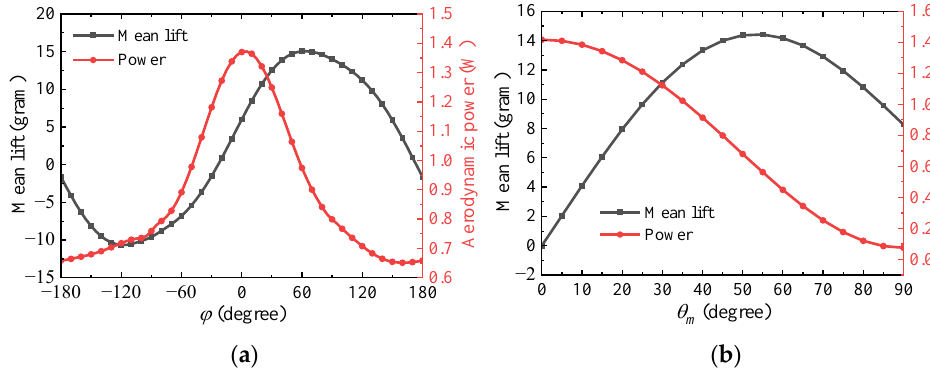
Figure 18. Aerodynamic performance of two typical states. ( a ) Lift and power with different phase angle φ , the pitching amplitude θ m is fixed at 45°. ( b ) Lift and power with different pitching amplitude θ m , the phase angle φ is fixed at 90°.